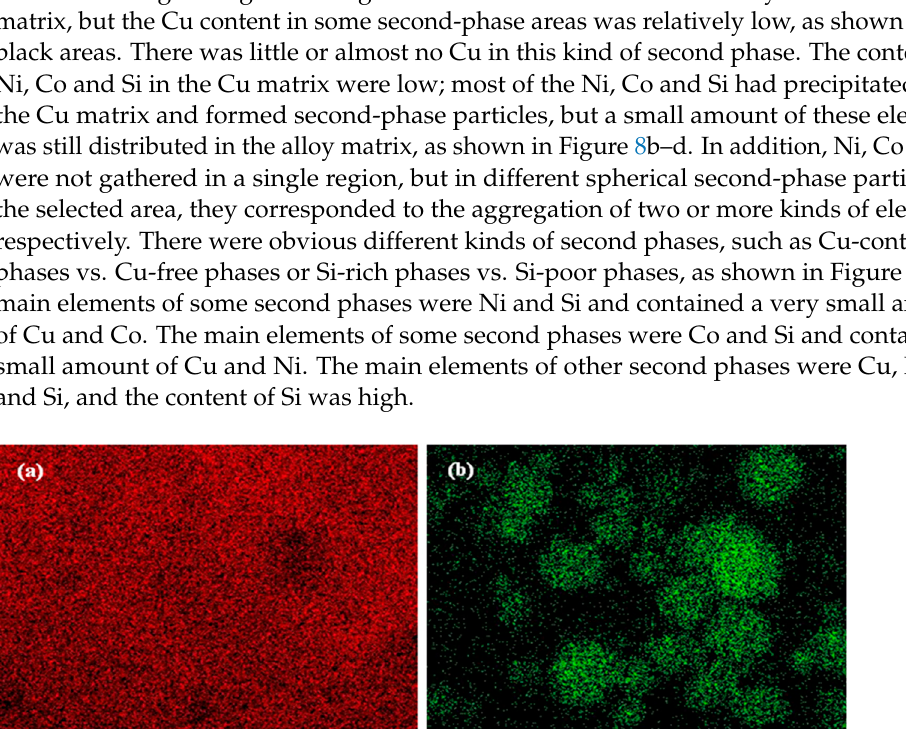
Figure 8. Area scanning images of the element distribution for the HADDF Z-contrast image of Figure 7b: ( a ) Cu; ( b ) Ni; ( c ) Co; ( d ) Si. Figure 9 shows the X-ray diffraction analysis of the Cu-1.34Ni-1.02Co-0.61Si alloy after cold rolling at 47% reduction with the DCT in liquid nitrogen for 6 h, 12 h, 24 h and 48 h. Figure 9 presents that the precipitated second-phase grains at all DCT times were Ni 2 Si, CoSi and Cu 15 Si 4 . Figure 9. X-ray diffraction analysis of the Cu-1.34Ni-1.02Co-0.61Si alloy after cold rolling at 47% reduction with the DCT in liquid nitrogen for 6 h, 12 h, 24 h and 48 h.